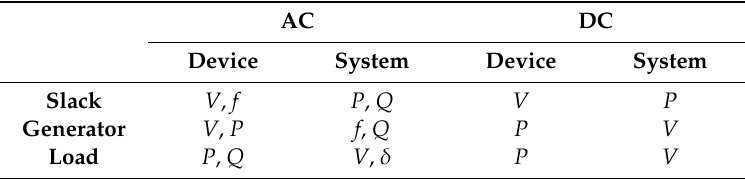
Table 1. AC and DC state variables determined by the device or given from the system